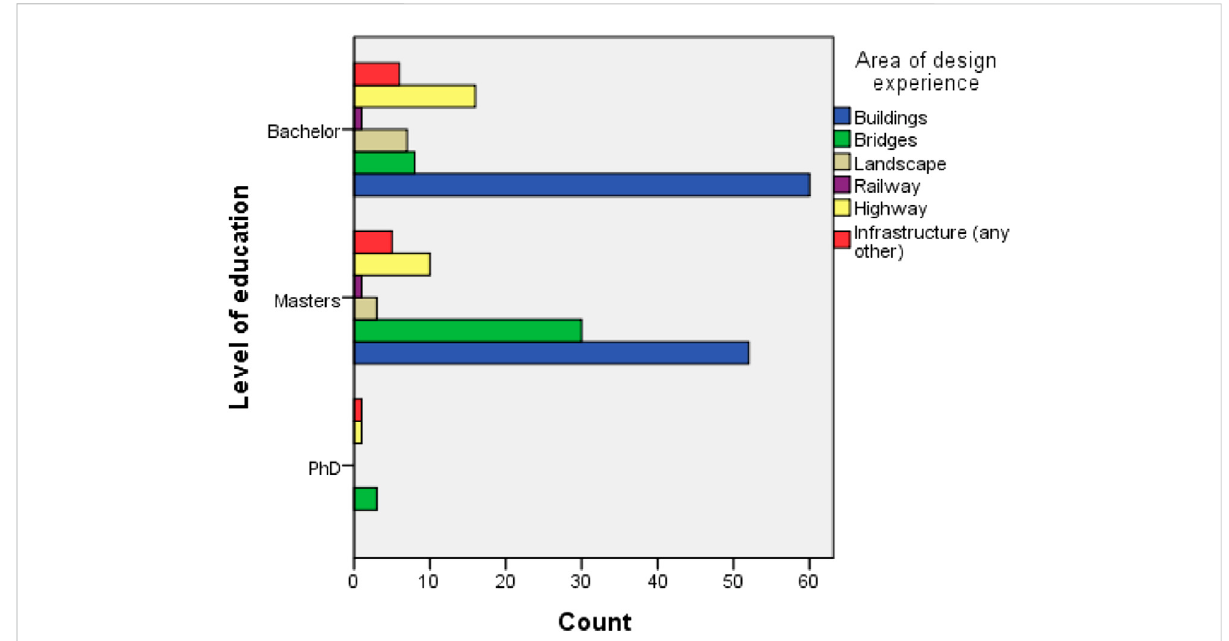
FIGURE 1 Cross-tabs of the level of education and areas of design